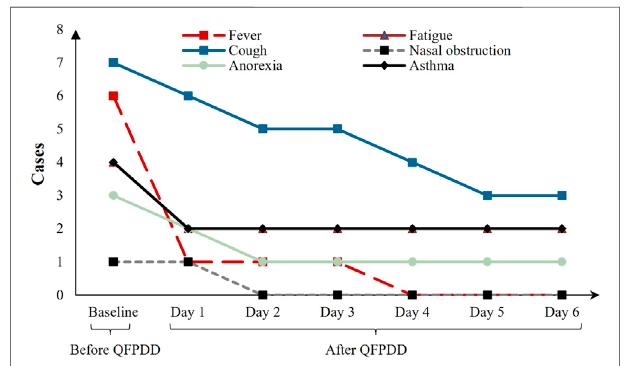
Body temperature, ° C